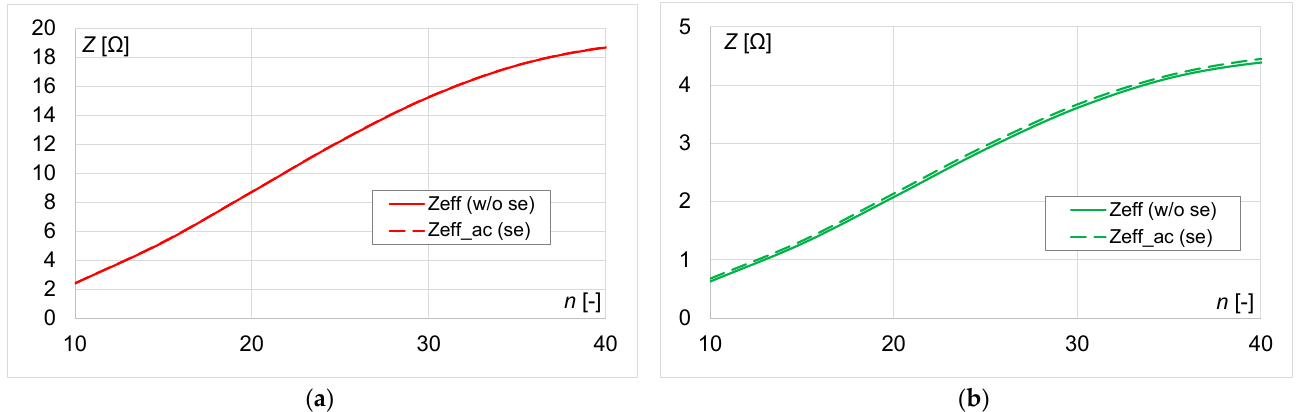
Figure 5. Load impedance for the cases with and without skin effect at 1 MHz for the small coil at